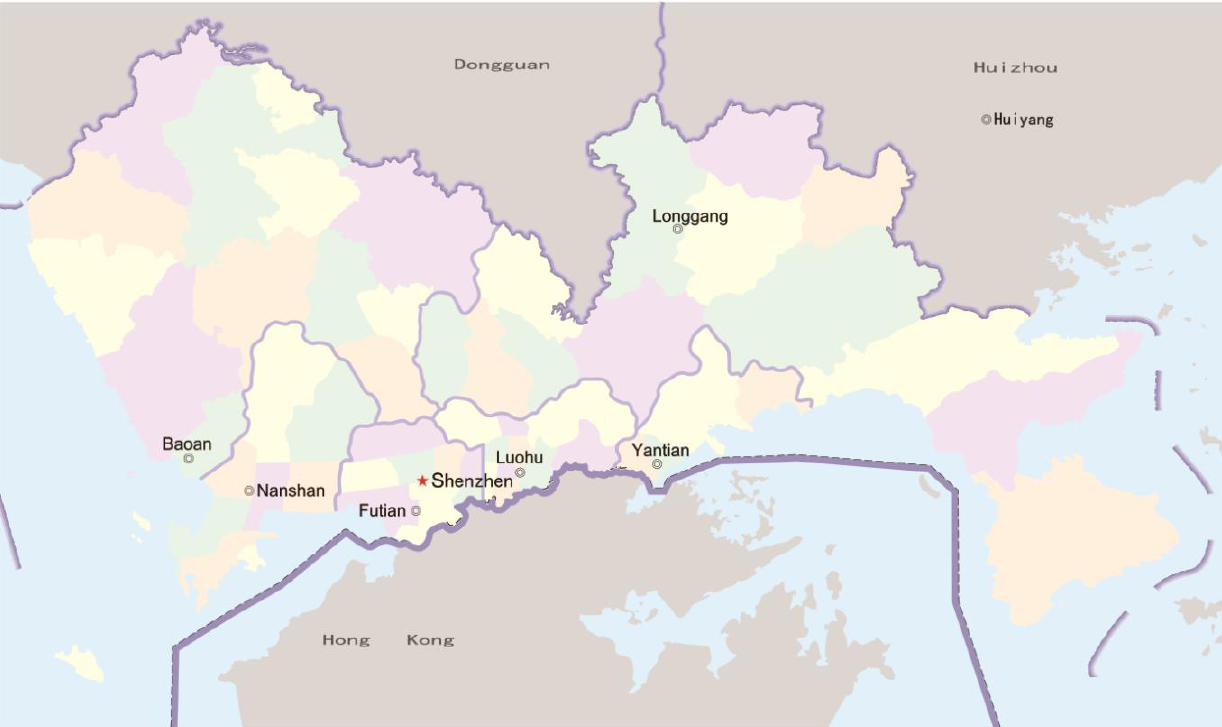
Figure 2. A map of